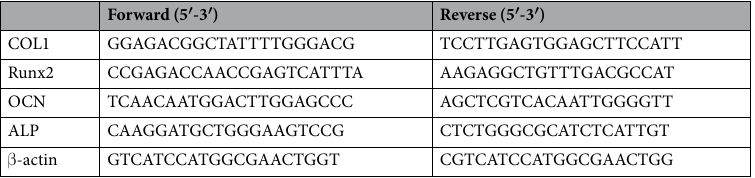
Table 1. The primers for